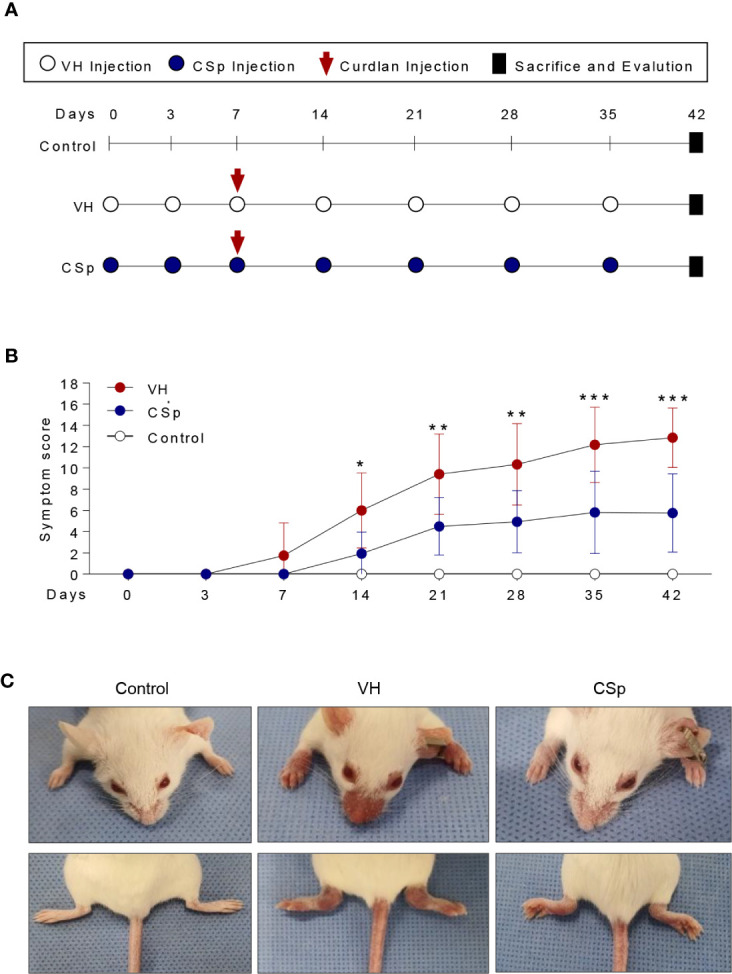
CSp treatment reduces clinical symptoms in SKG mice. (A) SKG mice were treated with CSp or vehicle i.p. for 6 weeks. (B) The arthritis scores were determined based on clinical arthritis severity in each group (n = 10 mice for each group). The values of the left panel are the mean ± SD. *P < 0.05, **P < 0.01, ***P < 0.001, by two-way analysis of variance (ANOVA). (C) Representative mouse from each group at the end of the experiment. CSp: Clonorchis sinensis-induced protein; VH: vehicle group.